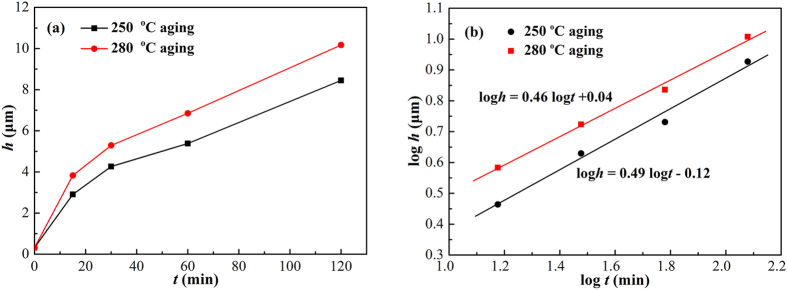
Thickness of the interfacial Cu6Sn5 as a function of aging time: (a) h–t; (b) logh–logt.